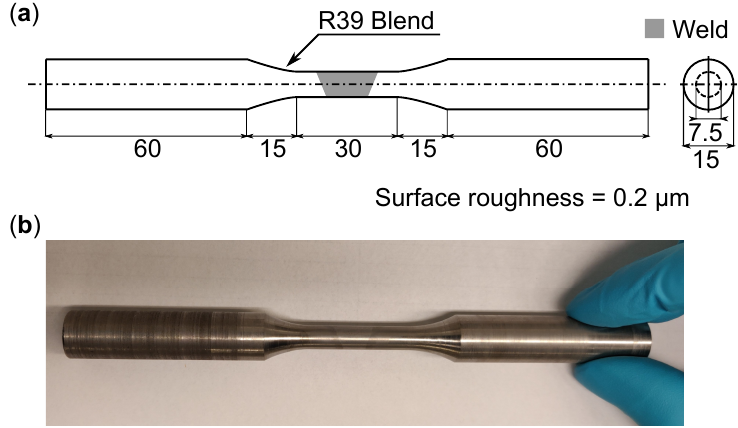
Figure 2. Test specimen used in the material model parameter estimation experiments: ( a ) dimensions of the dog-bone specimen, and ( b ) manufactured dog-bone specimen. The dimensions are provided in mm unless stated differently. The schematic is not drawn to scale.